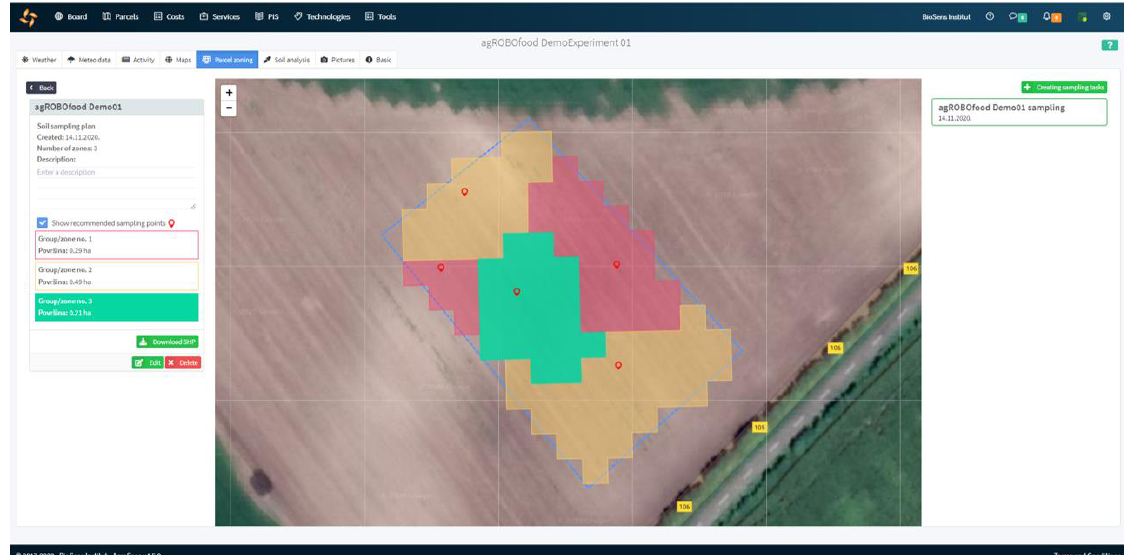
Figure 2. The results of the executed algorithm for proposing optimal sampling points within the AgroSense platform. Each color represents different management zones, while pin markers represent the optimal sampling points per